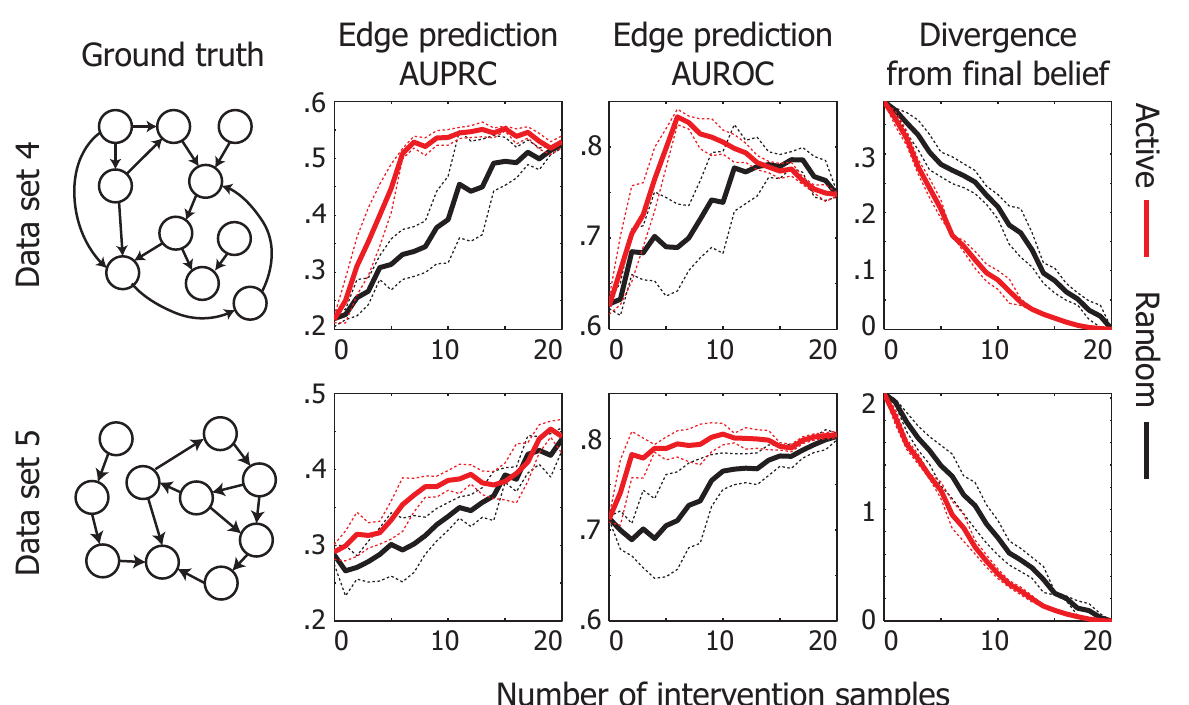
Fig 4. Reconstruction performance on DREAM4 benchmark data. The results are summarized over five trials. The dotted lines are drawn at one standard deviation from the mean in each direction. Active learner achieves higher accuracy and faster convergence than random learner.